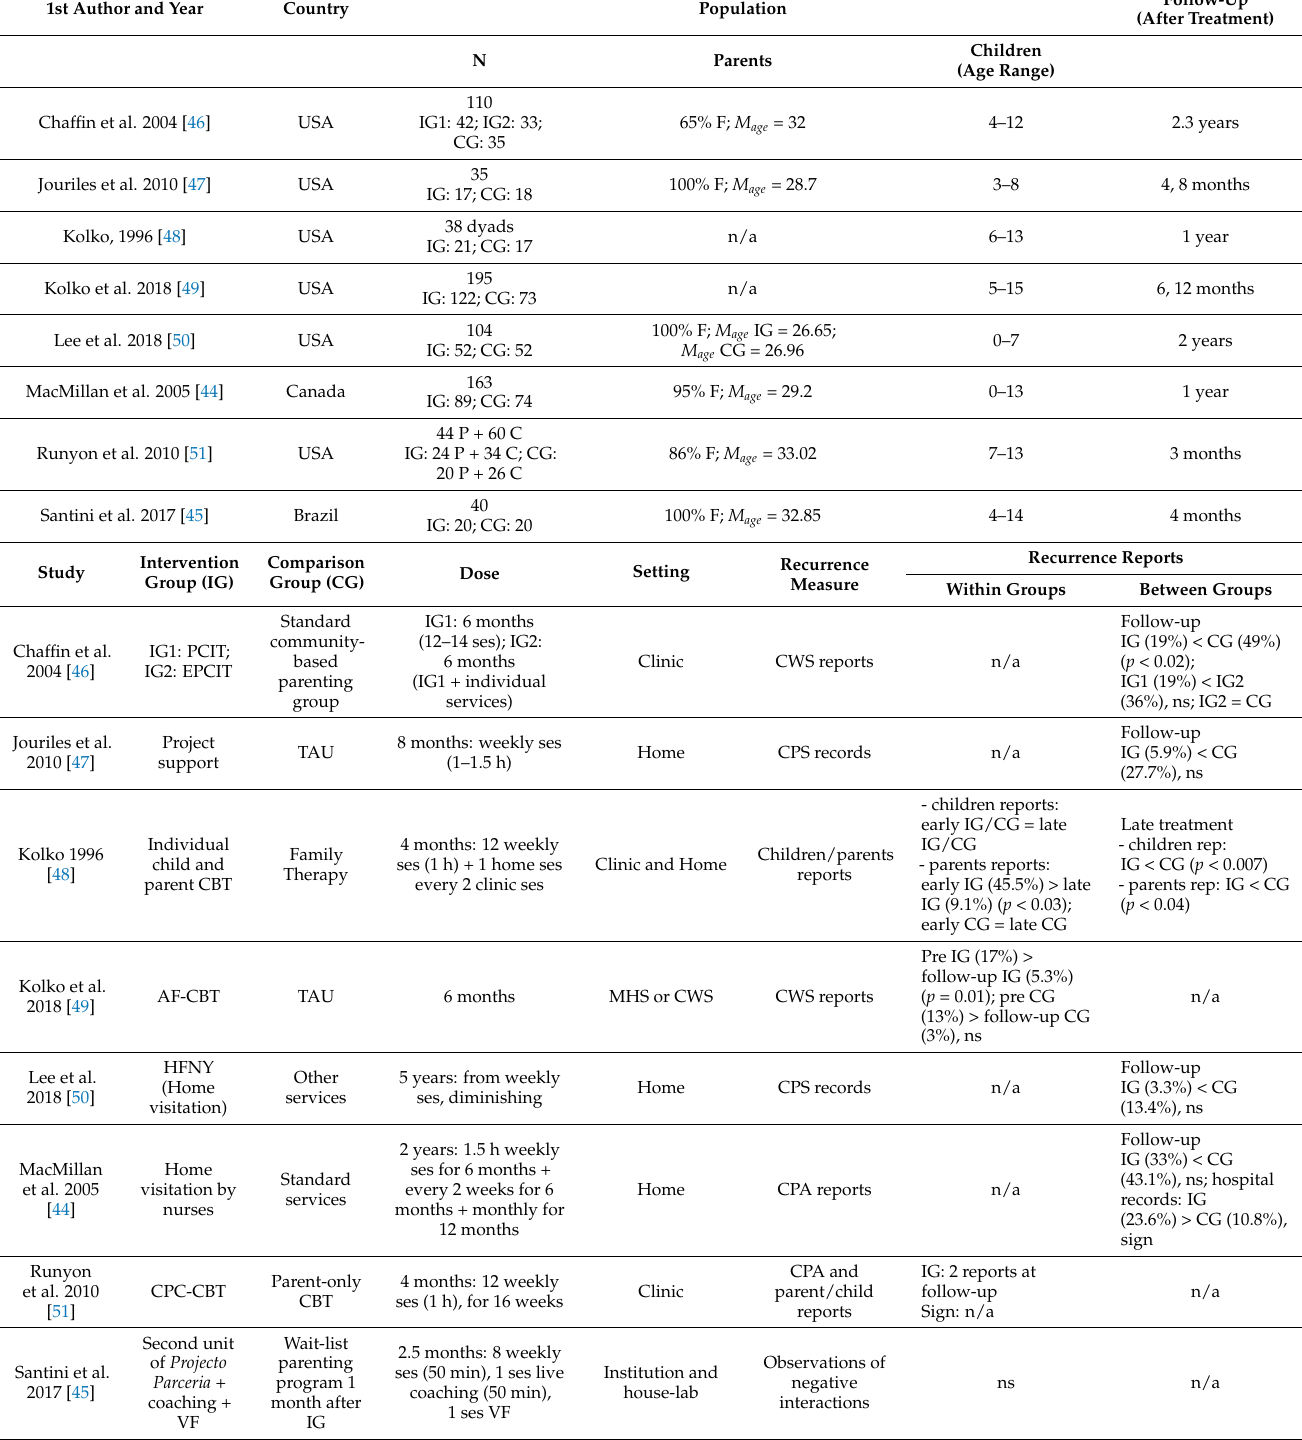
Table 1. Characteristics of the included